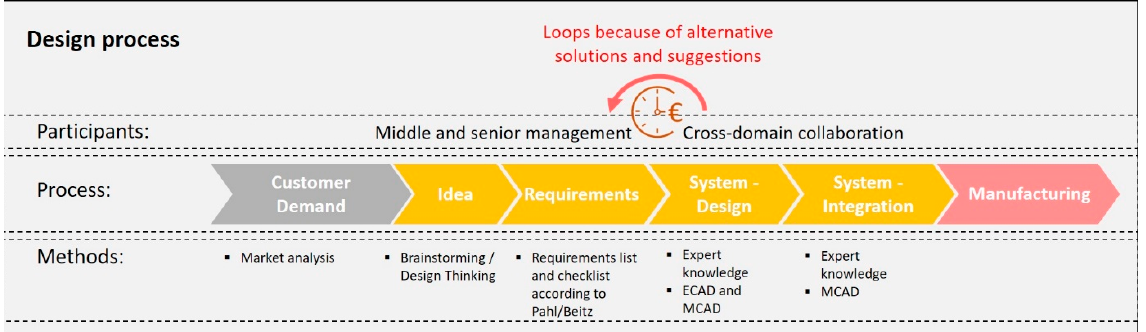
Figure 7. Overview of the design process for PUC 6 with the used methods and participants.